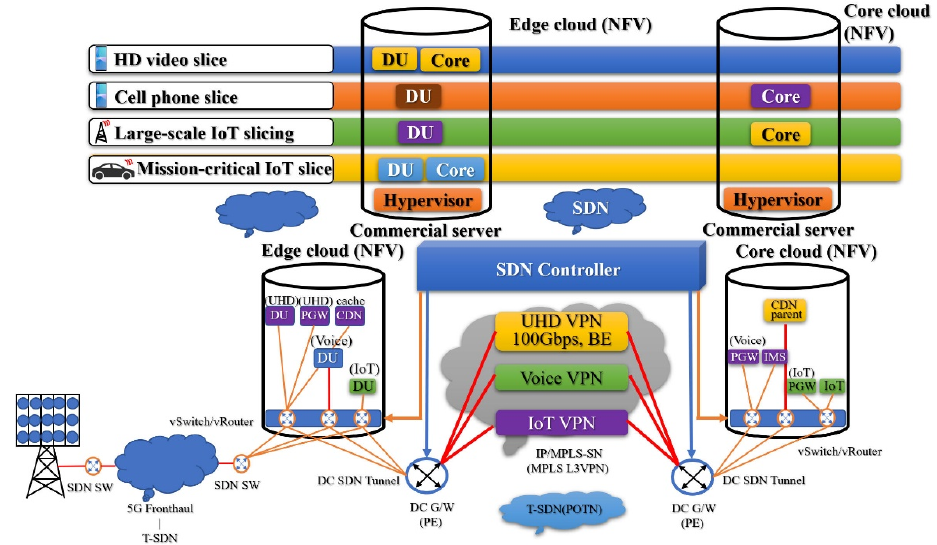
Figure 12. A diagram of 5G network slicing technology.